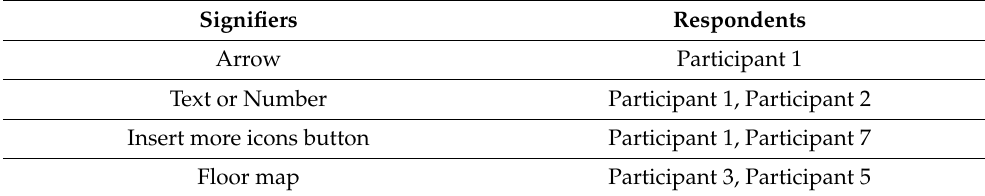
Table 6. Suggested signifiers by test participants for museum navigation.